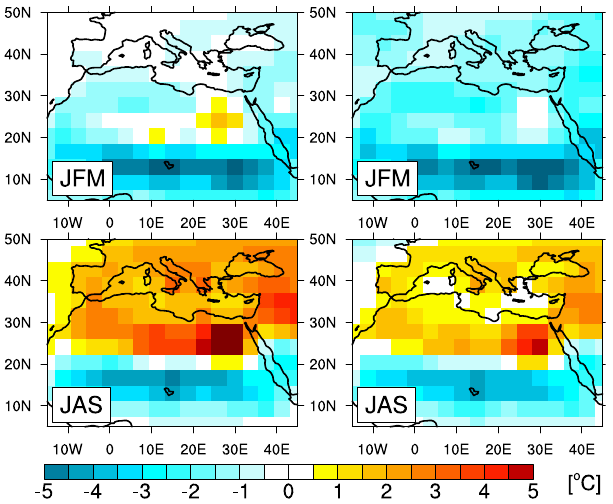
Fig. 11. Anomalies of summer (JAS) temperature at different depth levels, 9K1 vs. CTRL (left column) and 9K2 vs. CTRL (right column).